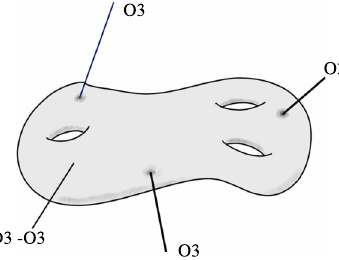
Fig. 1 Schematic picture of the compact space and the locii of the orientifold planes and D